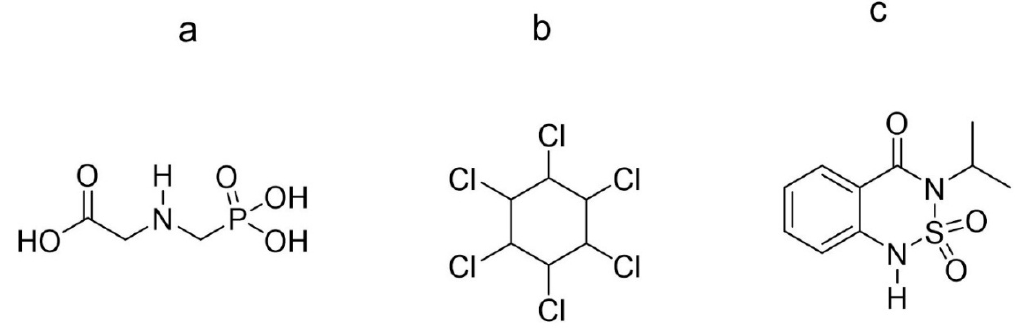
Figure 1. Chemical structure of ( a ) glyphosate, ( b ) lindane ( c ) bentazone.